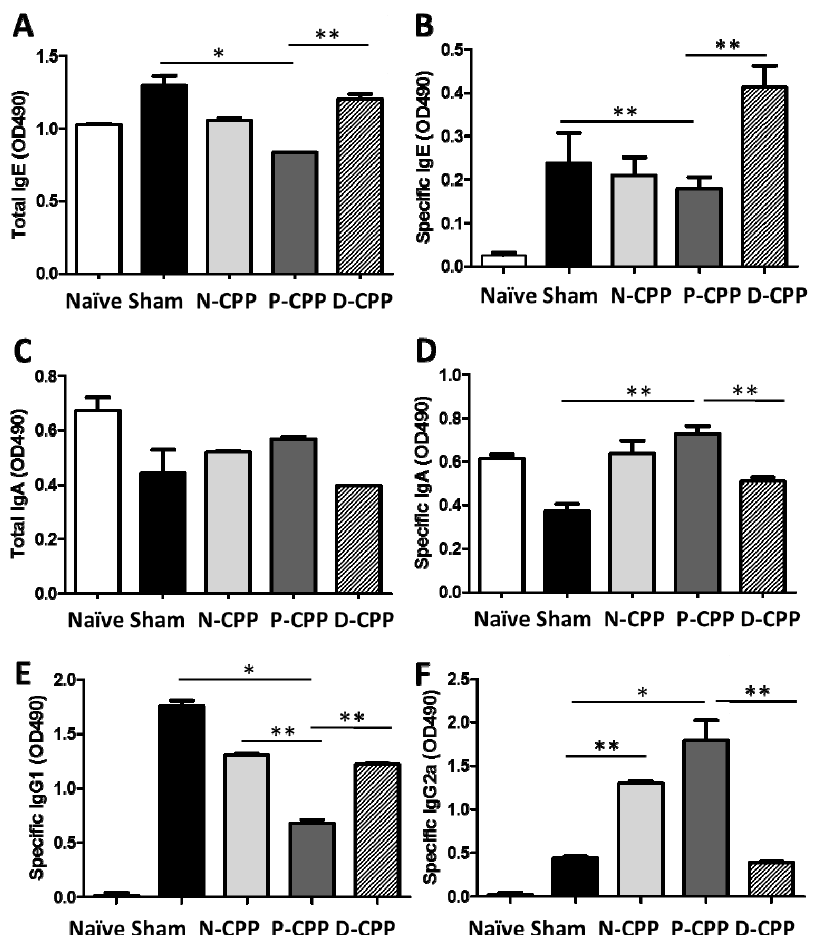
Figure 3. Effects of oral feeding with differently phosphorylated CPP-III on the immune response of OVA-sensitized mice. OVA-sensitized mice were fed differently phosphorylated CPP-III for a period of 6 weeks, and the serum levels of total IgE ( A ), OVA-specific IgE ( B ), total IgA ( C ), OVA-specific IgA ( D ), OVA-specific IgG1 ( E ), and OVA-specific IgG2a ( F ) were determined by ELISA. Data represent the mean ± SE of individual mice in the group. * p < 0.05; ** p <